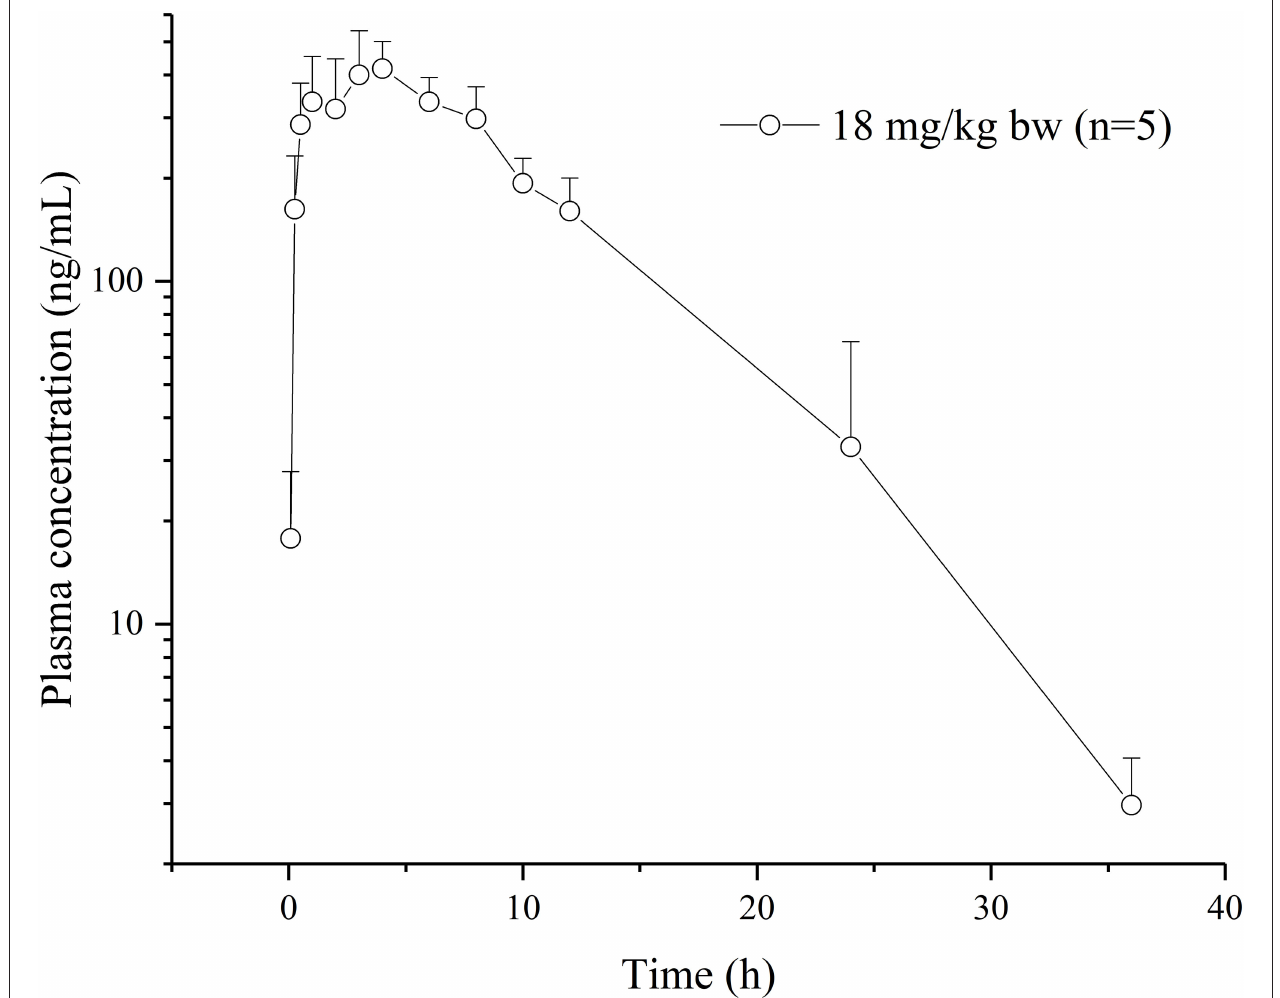
FIGURE 2 | Plasma concentration-time curves of vitacoxib in rats ( n = 10) after an oral administration of 18 mg/kg bw.